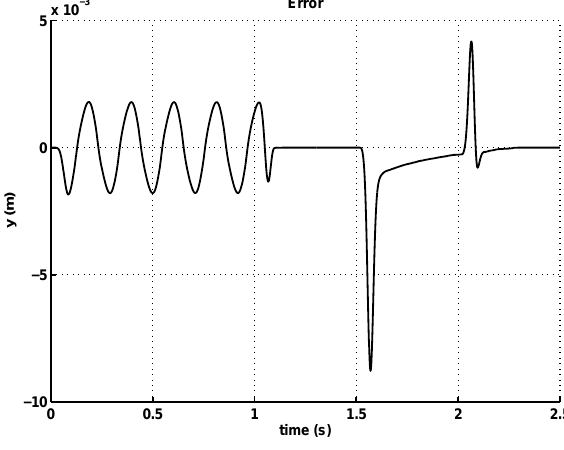
Figure 6: Tracking error for Fig. 5.